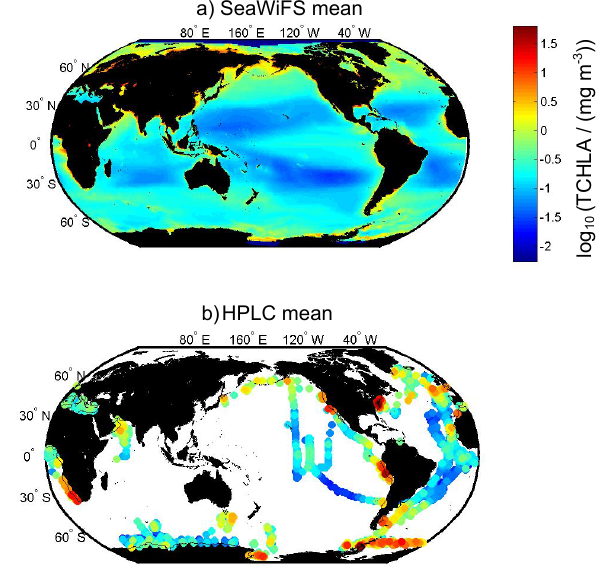
Figure 6. (a) Climatological mean (2000–2007) chlorophyll a con- centration (mgm − 3 ) from SeaWiFS (scaled to 1 ◦ resolution) and (b) surface TCHLA (mgm − 3 ) from MAREDAT (averaged over the upper 20m and scaled to 1 ◦